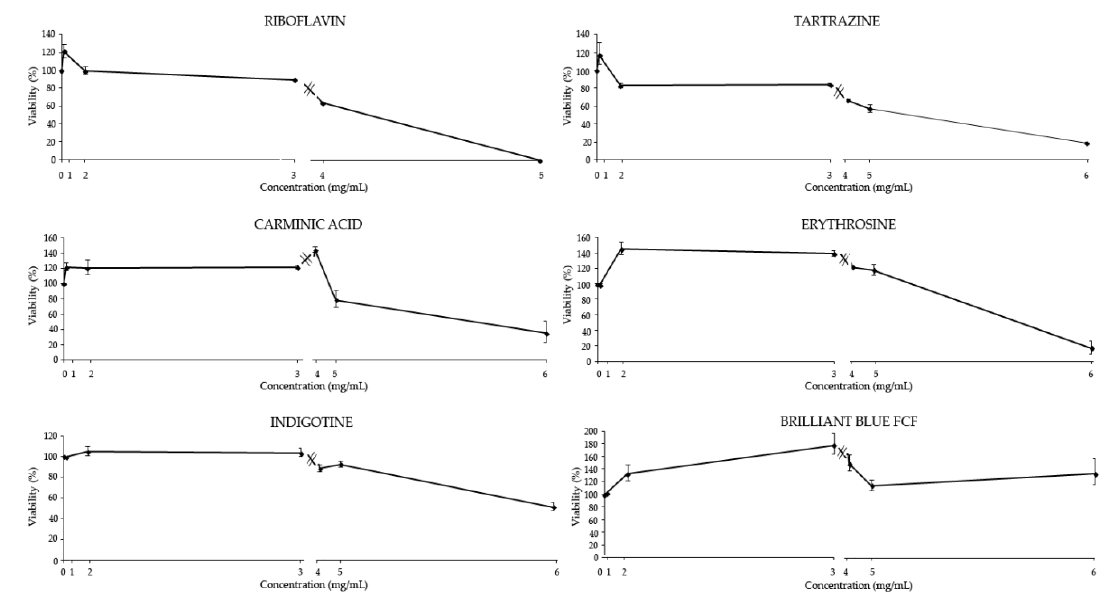
Figure 4. Effect of food coloring on HL-60 cells viability. Viability of the promyelocytic human leukemia cells (HL-60) treated with different concentrations of food colorings for 72 h. Each point represents the growing percentage with respect to its control. Values represent the mean ± SE from three independent experiment. Numbers 1–6 indicate the different dilutions tested (see Table 1).